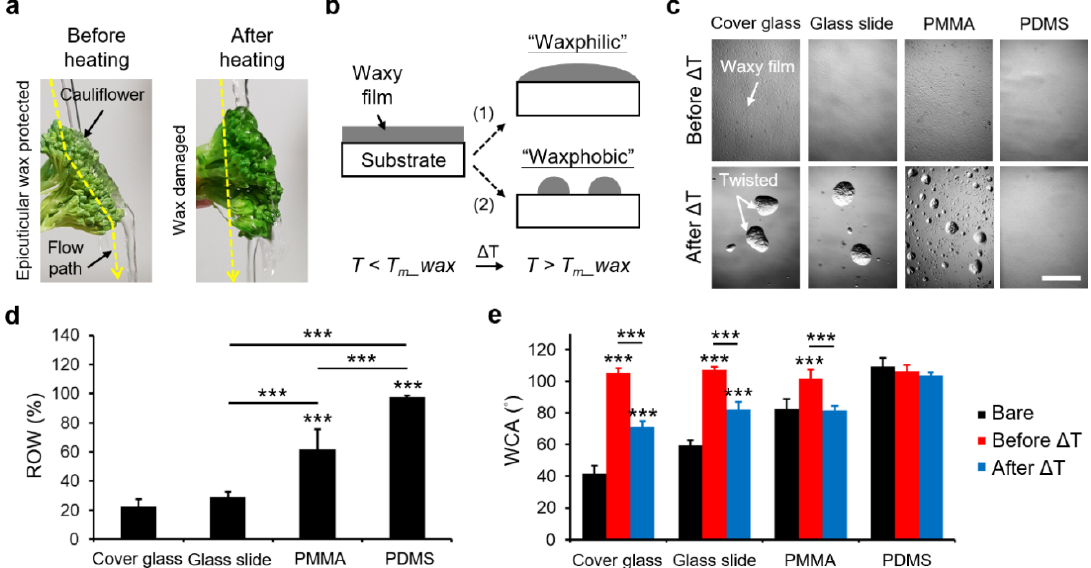
Figure 1. Reconstruction of molten wax films on different substrates. ( a ) Observation of the water flow paths through cauliflowers before and after heating. The heating condition was a boiling bath for 30 s. ( b ) Illustration showing the “waxphilic” and “waxphobic” phenomena at a temperature close to or higher than the melting point of wax. ( c ) Micrographs showing the derived architectures of molten wax films on cover glass, silane-coated glass slide, PMMA, and PDMS substrates, respectively. The heating condition was a hot plate at 65 °C for 30 s. The results after Δ T were acquired at room temperature. Scale bar = 500 μ m. ( d ) Comparison of the ratio of wax area (ROW) carried on the substrates after Δ T. The substrate area for the examination was 1553 × 1125 μ m 2 . ( e ) Comparison of water contact angle (WCA) on different substrates during no treatment (bare), and before and after heating conditions. Data represent the mean ± SD, n = 4 in ( d ) and n = 6 in ( e ). *** p < 0.001.